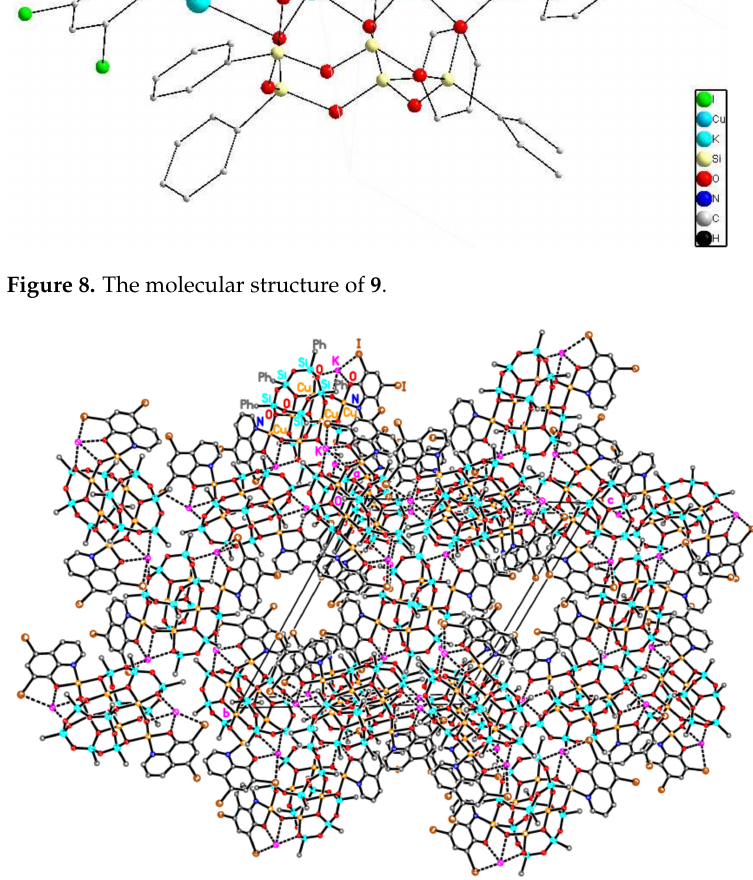
Figure 9. The 3D coordination polymer structure of 9